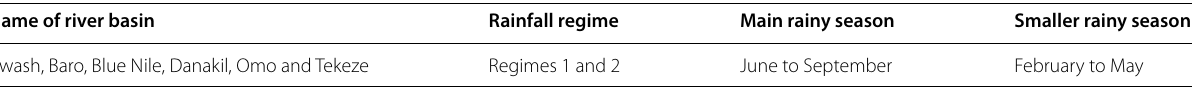
Table 1 Name of main river basins and rainfall regimes of the area Name of river basin Rainfall